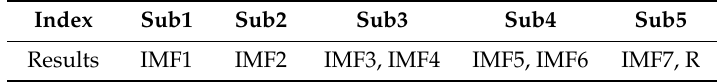
Table 2. The new subsequence after being processed by fast ensemble empirical mode decomposition (FEEMD).